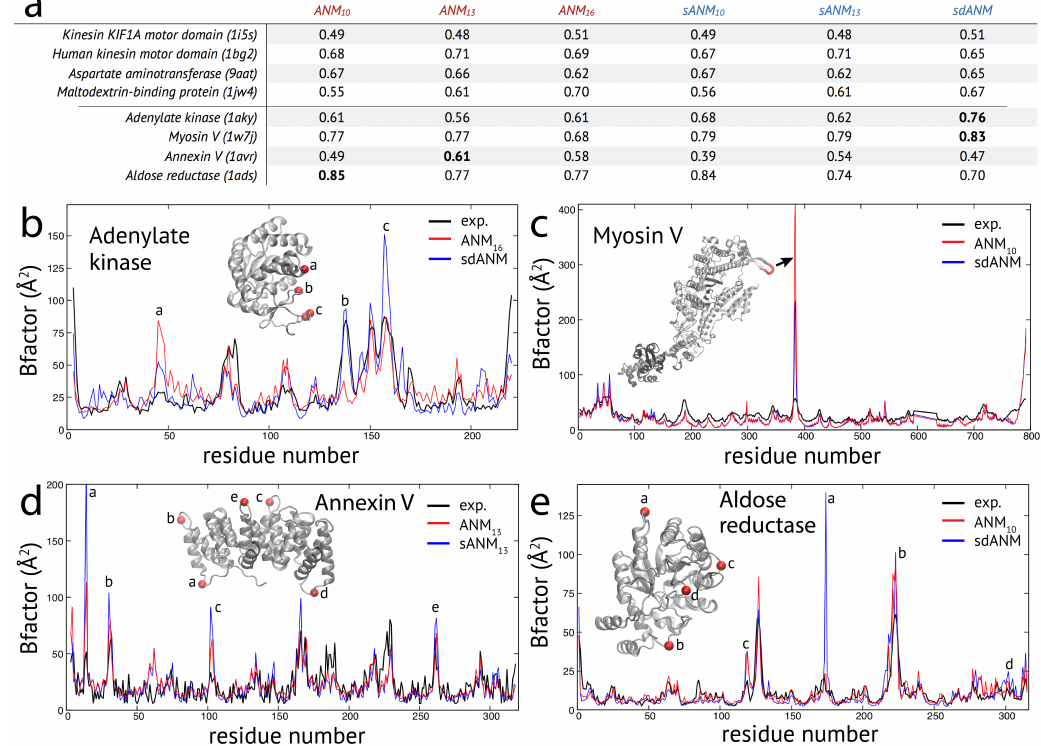
Figure 1. Fluctuation dynamics in studied proteins. ( a ) Table of correlation coefficients for protein structures obtained from the considered model variants. For each of the two identified groups, four examples are shown. In the second group, bold numbers indicate for each protein the highest correlation of experiment and model predictions. ( b – e ) B-factor profiles for four protein structures are shown. Model predictions are displayed as red and blue lines; corresponding experimental data is shown in black. In the B-factor profiles, positions where model estimates are significantly poor were marked for each protein. The corresponding regions in the respective protein structure are also